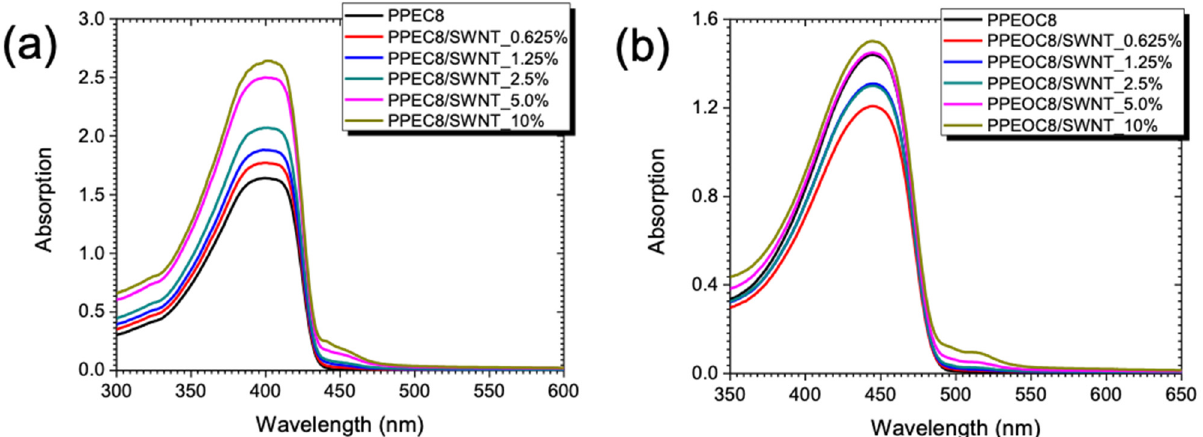
Figure 2. UV-Vis solution spectra of ( a ) PPEC8/SWNT and ( b ) PPEOC8/SWNT in DCB. The SWNT loading relative to PPE amount is 0 wt%, 0.625 wt%, 1.25 wt%, 2.5 wt%, 5 wt% and 10 wt%. The PPE concentration is set as 1 mg/30 mL.